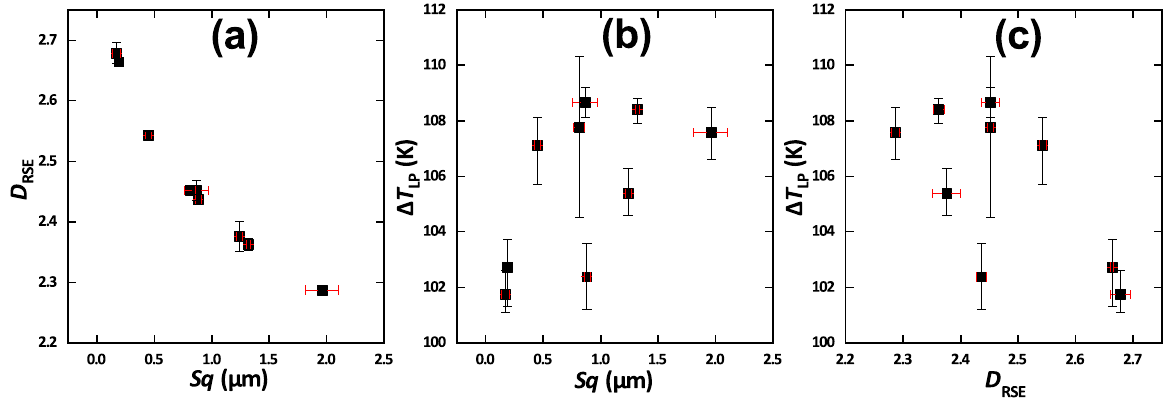
Figure 6. The relationships of: ( a ) D RSE - Sq , ( b ) ∆ T LP - Sq , ( c ) ∆ T LP - D RSE . ∆ T CHF could vary from 94.1 K to 104.3 K, but there was no clear relationship of Sq or ∆ T CHF - D RSE , indicating that brass surfaces morphology could not directly influence ∆ T CHF within the experimental scope of this